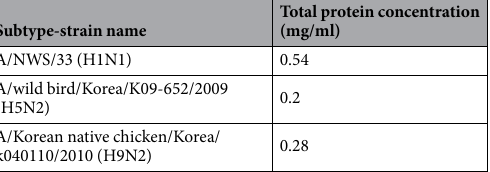
H9N2 subtype virus and control (without inoculation of any virus) in pellet forms after freeze-drying process. An absorbance was extracted from the transmission measurement through a pallet type sample in a same way described in ref. 10. The H9N2 and control samples have no recognizable absorption features in the THz spec- trum (Fig. 1a) due to superposition of many protein vibration modes and inhomogeneous broadening of absorp- tion features 17 . In contrast to earlier works 10–12 , it is not easy to define fundamental resonance frequency to design